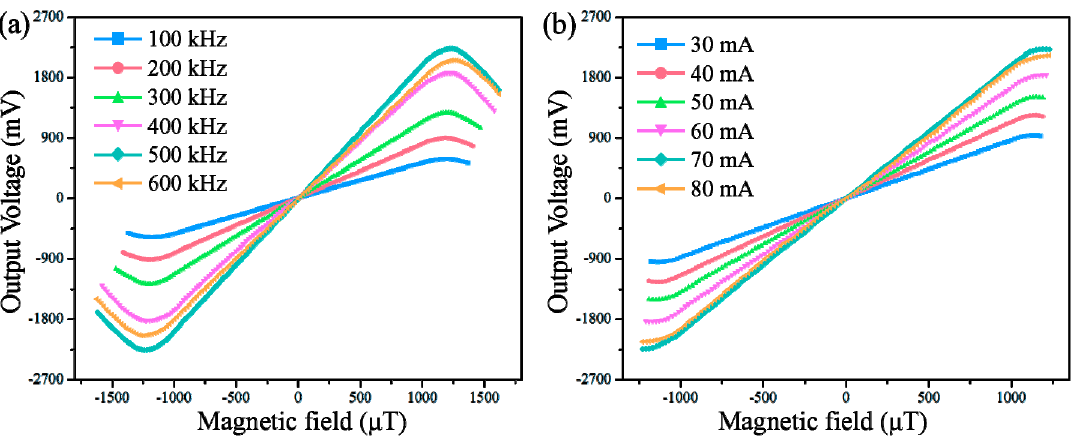
Figure 4. ( a ) The sensor response for different levels of excitation frequency at an excitation current of 70 mA; ( b ) The sensitivity of the sensor as a function of the magnitude of the excitation current.